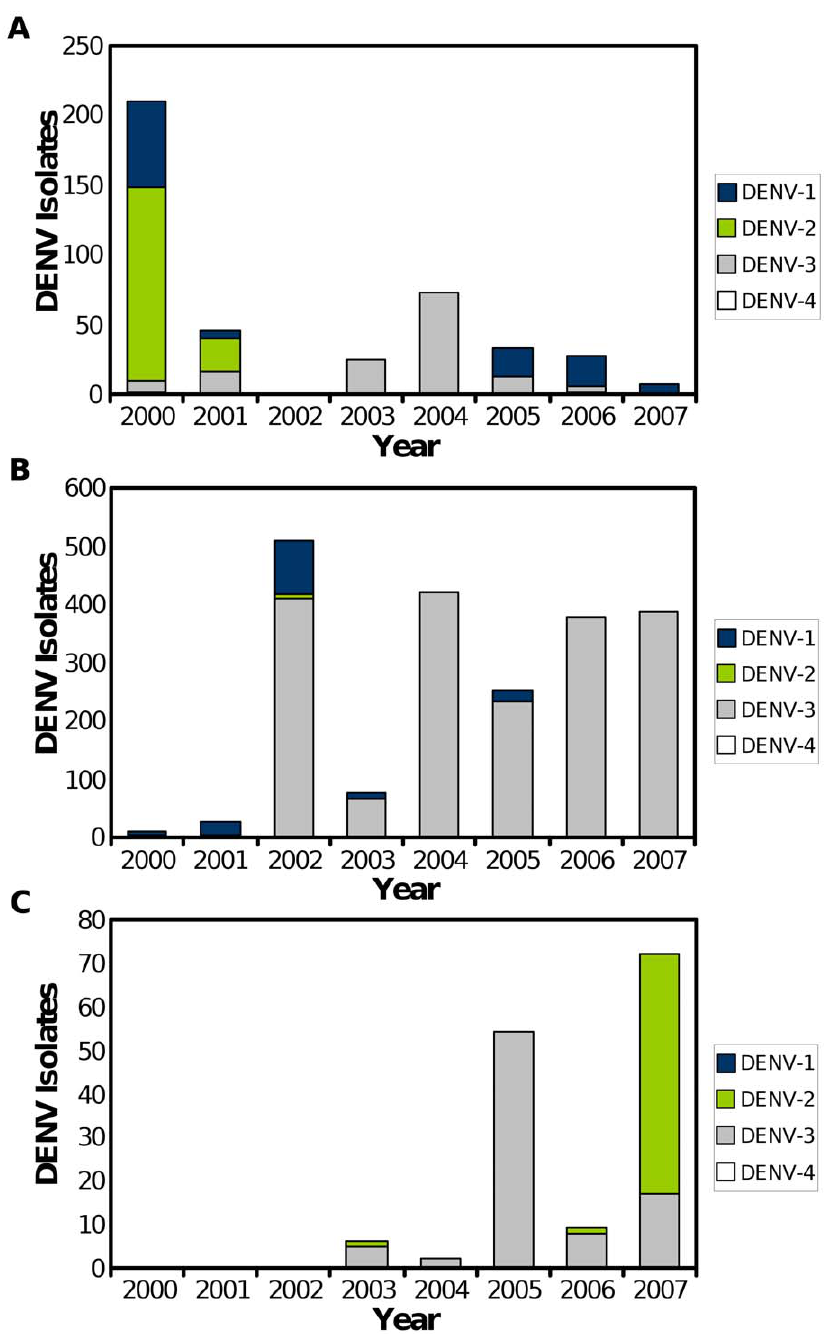
Figure 2. DENV serotypes circulating in western South America, 2000–2007. DENV serotypes circulation was analyzed based on different regions, including (A) Ecuador and northwestern Peru (Tumbes and Piura), (B) northeastern and central Peru (Iquitos, Yurimaguas, and La Merced), and (C) southeastern Peru (Puerto Maldonado) and Bolivia.